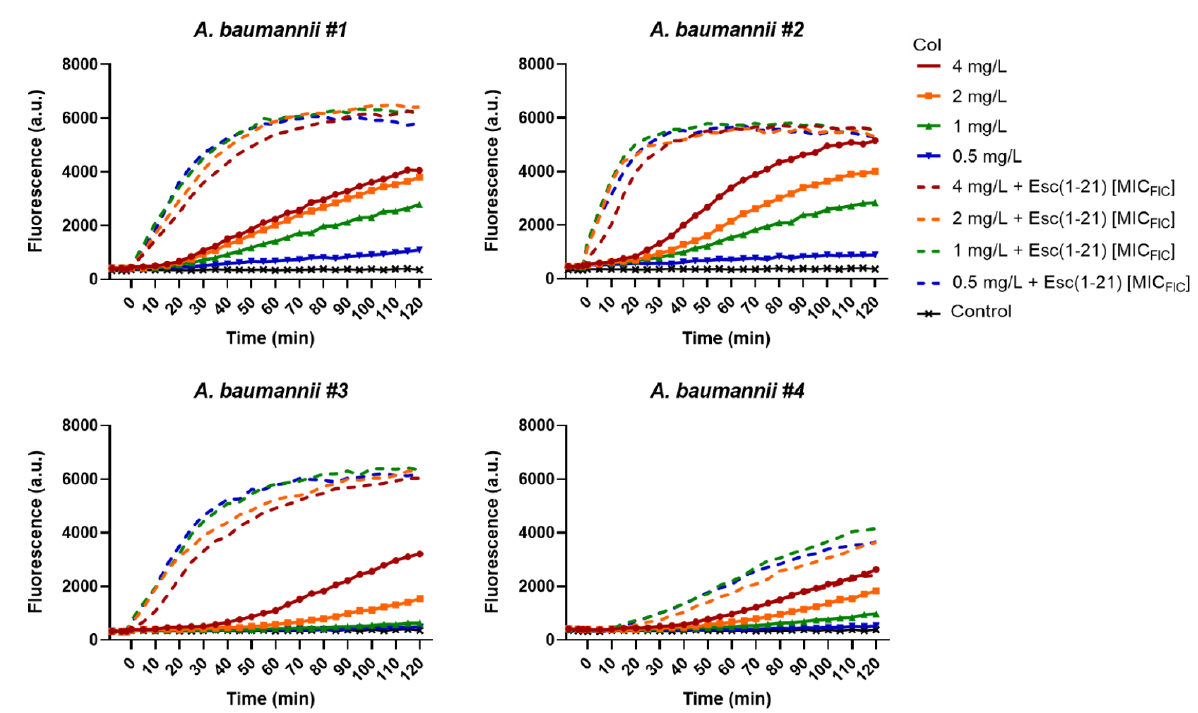
Figure 4. Kinetics of membrane permeabilization of all A. baumannii strains induced by the addition of different concentrations of colistin (Col), either when used alone or in combination with Esc(1-21) at its MIC FIC . Samples were incubated with 1 µ M Sytox Green in phosphate buffer saline as described in the Materials and Methods section, and changes in fluorescence were monitored. Controls were microbial cells with vehicle. Values correspond to one representative experiment of three.